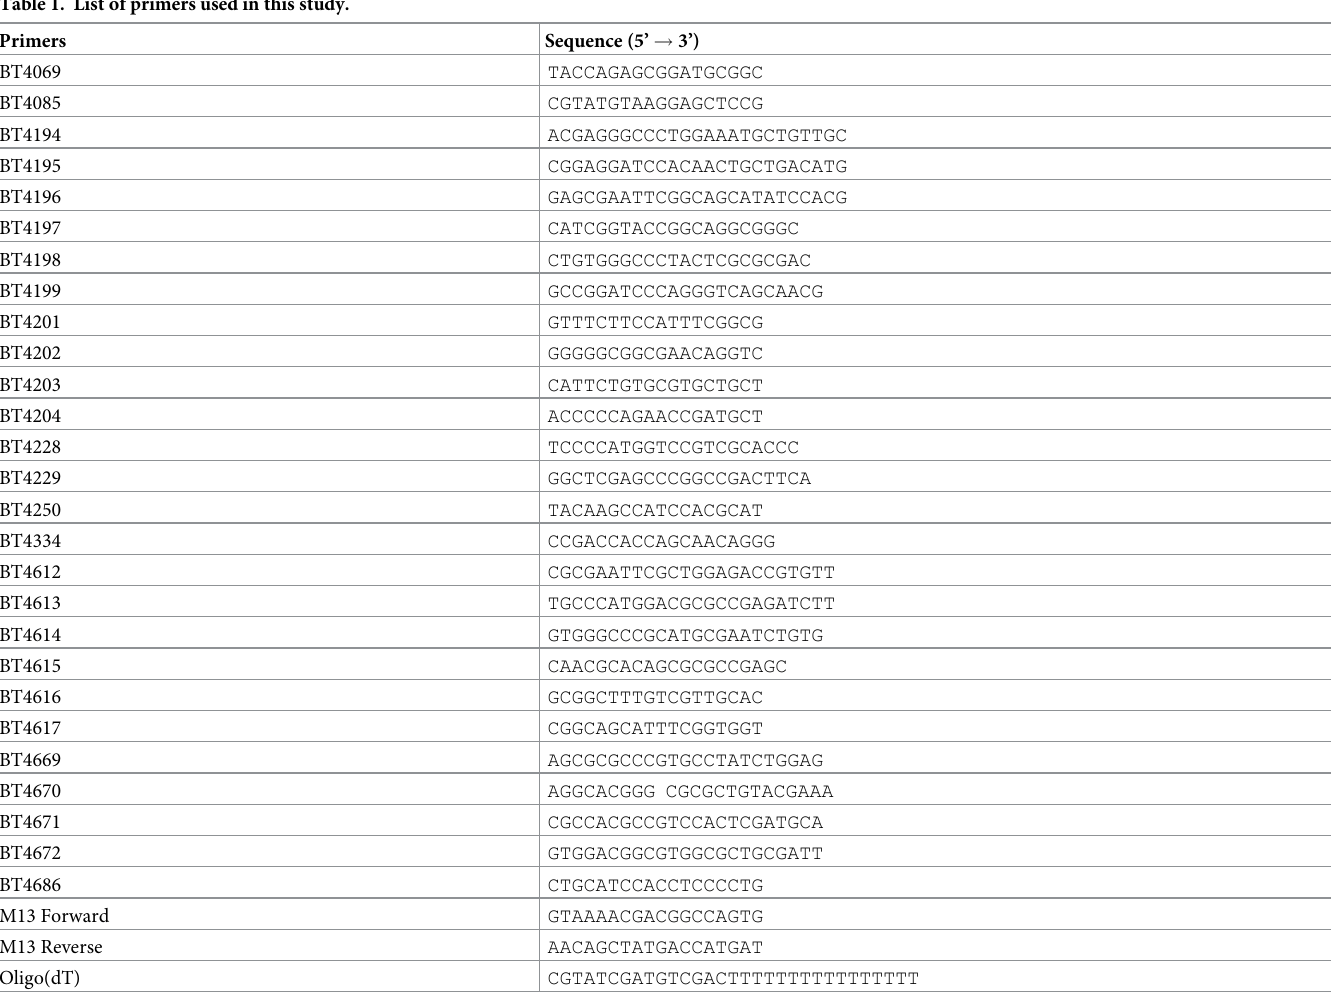
Table 1. List of primers used in this